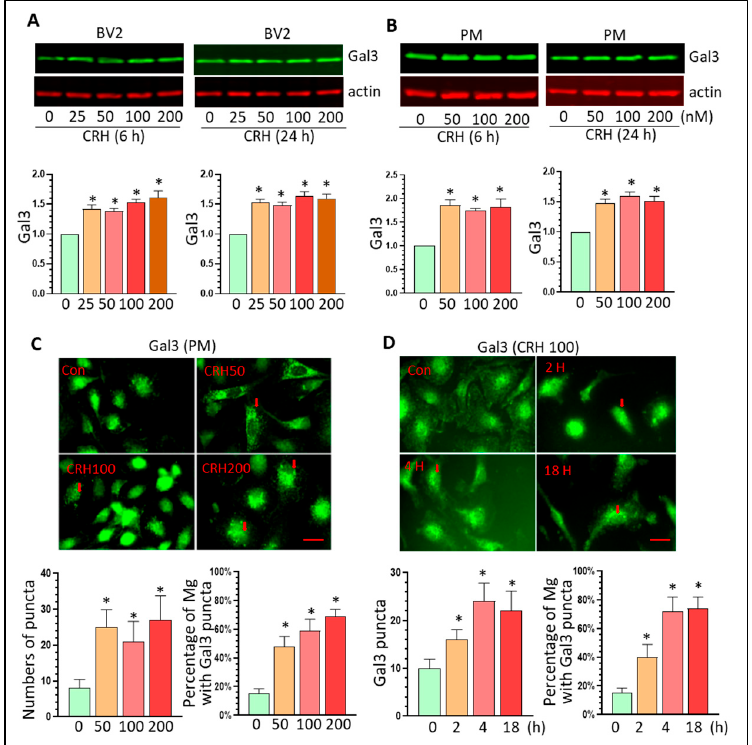
Figure 4. CRH increases Gal3 expression in vitro. ( A ): CRH increases Gal3 levels in BV2 cells (* p < 0.05); ( B ): CRH increases Gal3 levels in PM (* p < 0.05); ( C , D ): CRH increases the numbers of Gal3 puncta in Mg and increase the percentage of Gal3 puncta positive in Mg (* p < 0.05, scale bar = 10 µ). For Western blots, all experiments were independently repeated at least three times for statistical analysis.